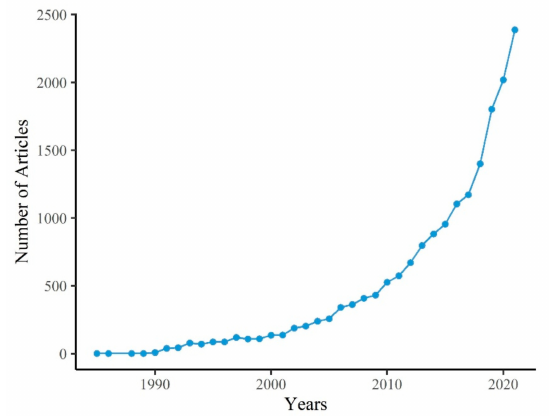
Figure 2. Scientific production of NDVI-related literature from 1985 to